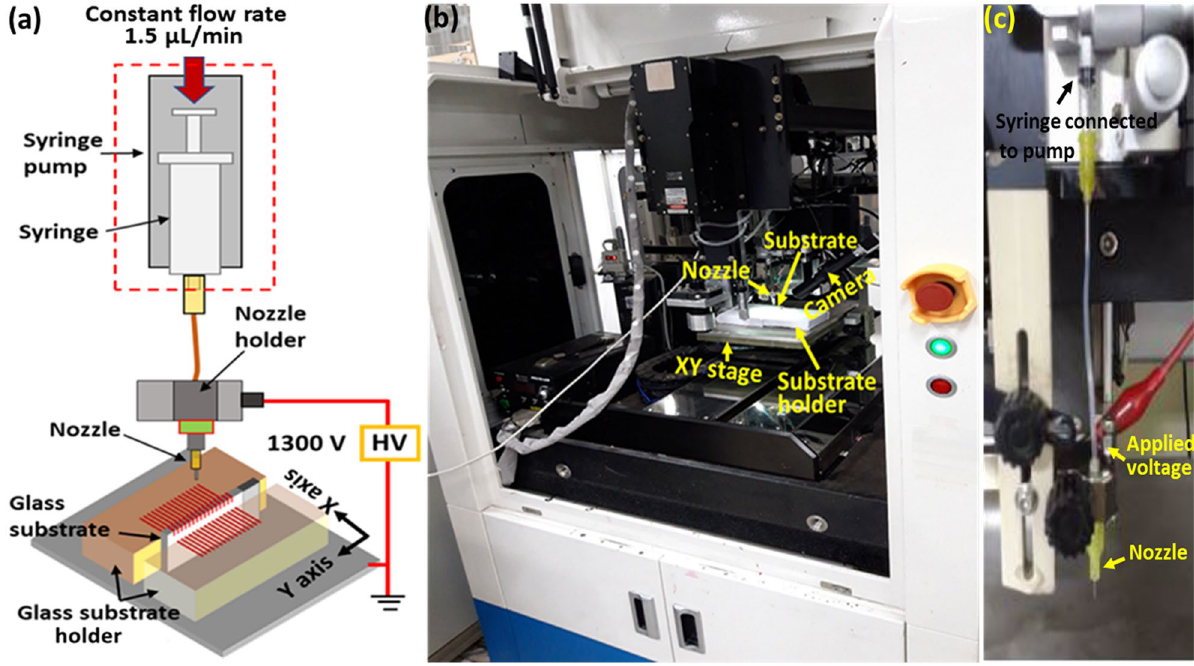
Figure 1. NFES printing system. ( a ) Schematic of NFES printing for connecting electrodes on both sides of glass substrate. ( b ) Photo of printing equipment. ( c ) Nozzle assembly of the